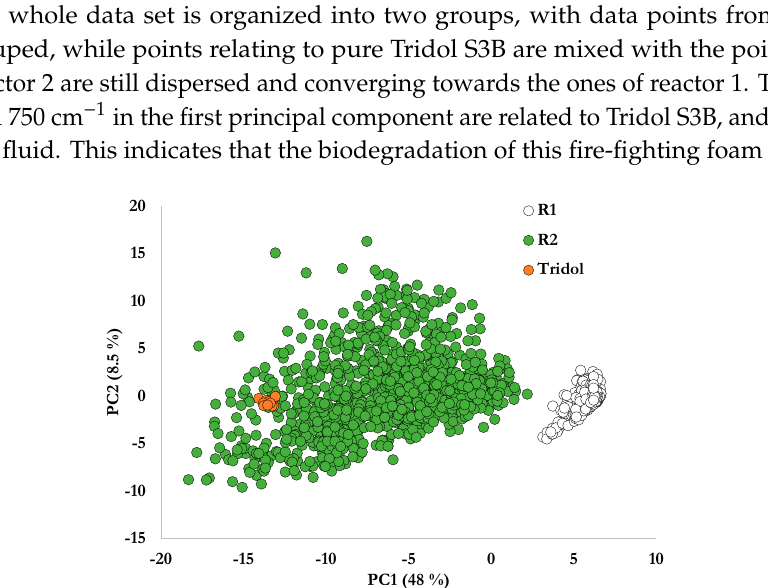
Figure 7. Explained variance ( a ), scores plot for the first two principal components ( b ) and loadings ( c ) for a PCA conducted on Raman spectra (after baseline correction and Singular Normal Variate (SNV)) obtained from measurements in reactors 1 and 2 during the biodegradation process of Tridol S3B.